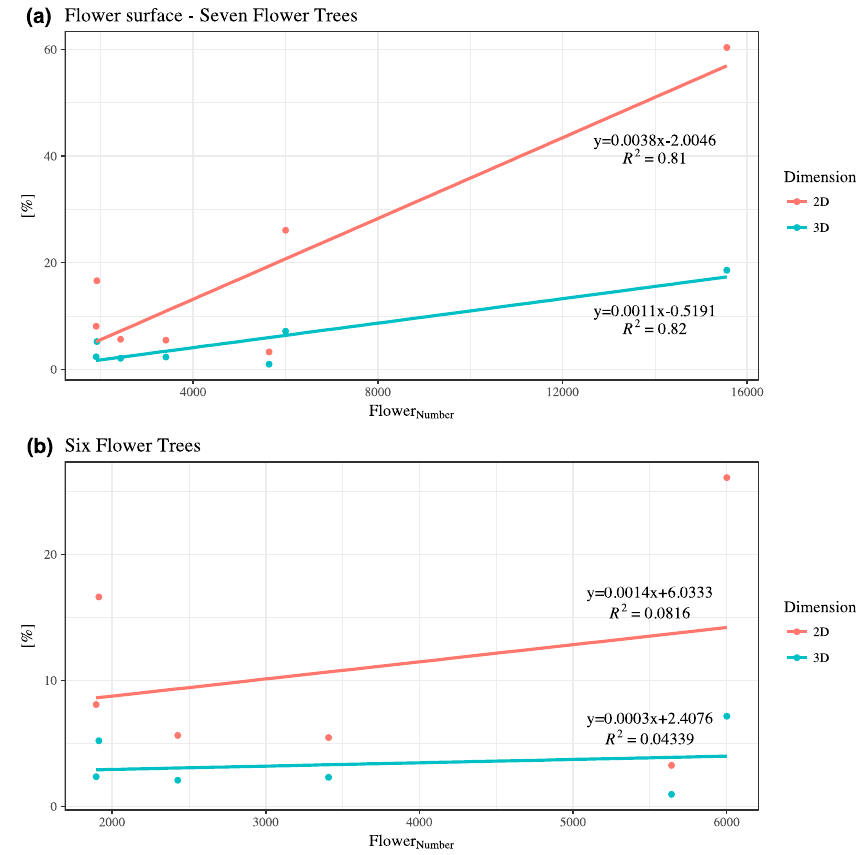
Figure 5. The 2D (red line) and 3D (blue line) flower surface of the ( a ) seven and ( b ) six Flower Trees. The percentage of flower surface detected by the unmanned aerial vehicle (UAV) is shown as a function of the number of flowers (Flower Number ). The linear regression functions and coefficients of determination appear in the legends. Table 3. Overview of analyzed Flower Trees and the characteristics of their flowers; counted inflorescence, and flowers per tree, flower per inflorescence, flower surface, flower weight in total, 1.0 cm 2 , and flower volume in cm 3 .